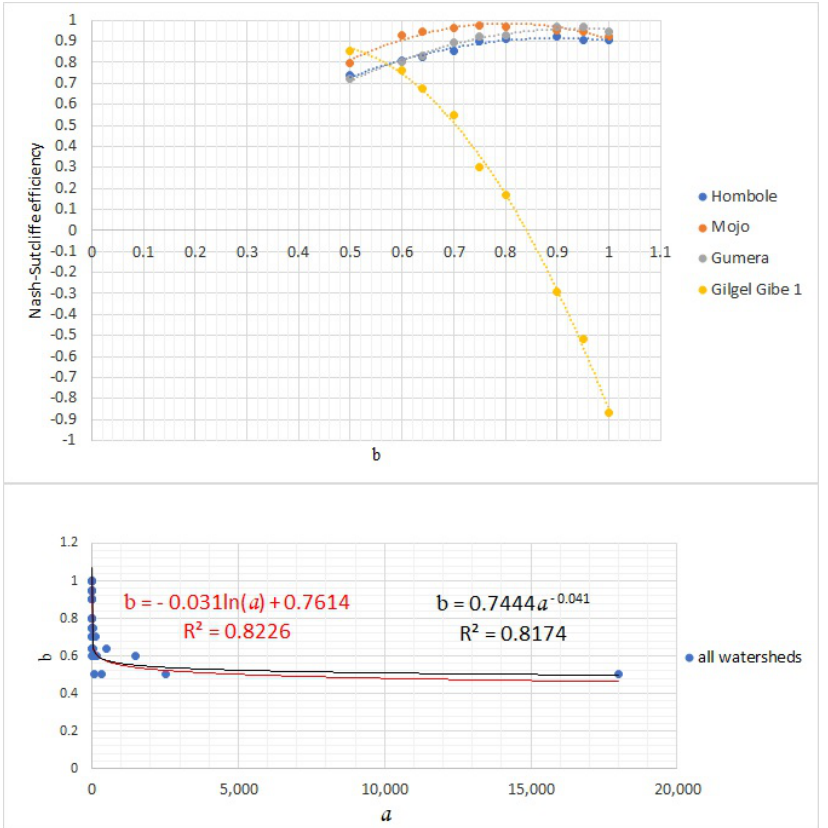
Figure 27. The relationship between exponent b versus the Nash–Sutcliffe efficiency and the coeffi- cient a versus the exponent b when the topographic factor is calculated using Equations (1) and